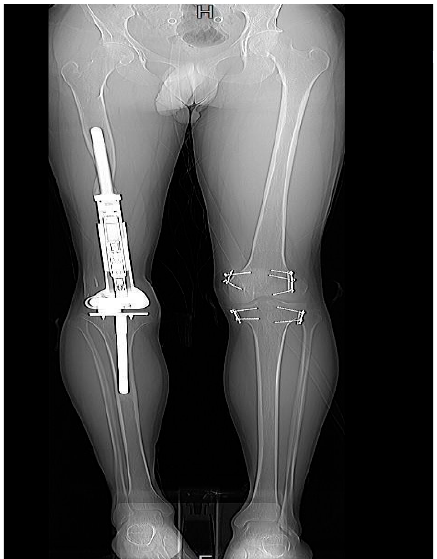
Figure 7. Patient 3 had undergone EDFE using MUTARS ® Xpand. However, due to an LLD of 37